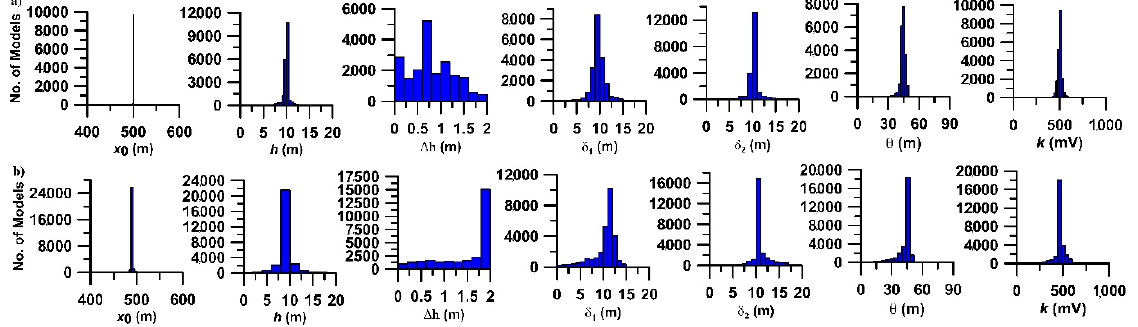
Figure 4. Histogram for Model 1: ( a ) Noise-free and ( b ) Noisy synthetic data.